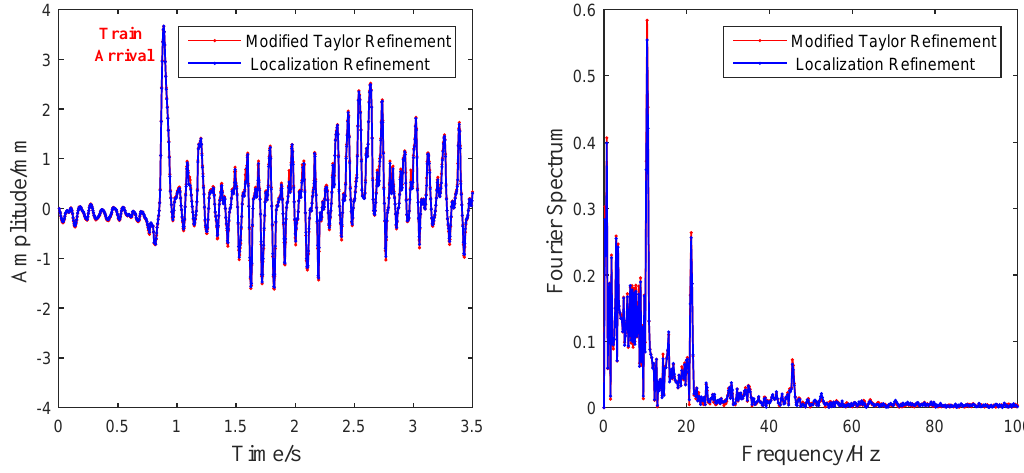
Figure 12. Vibration extraction results and their Fourier spectrums in the sound barrier